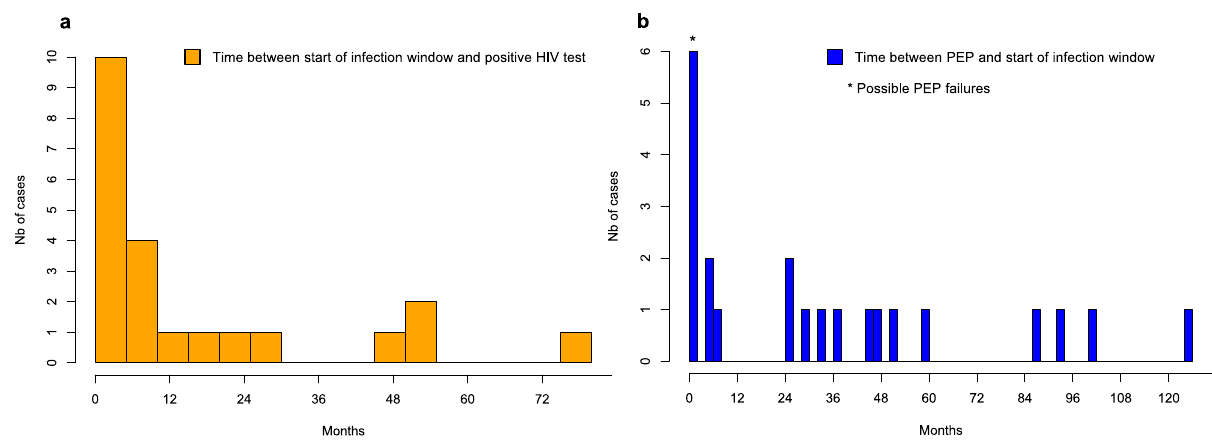
Fig. 3 Infection window and possible PEP failures: distribution among PEP seekers diagnosed with HIV ( n = 22). a Histogram showing the distribution of time between the earliest possible infection date and HIV diagnosis (orange bars). In 17 cases, the possible infection window was shorter than 2 years. b Histogram showing the distribution of time between PEP consultation and the start of the infection window (dark blue bars). PEP failure was possible in 6 cases (illustrated with *): the start of the infection window occurred within 3 months of PEP consultation ( n = 5), or HIV was diagnosed at 3 months ( n = 1). PEP: post-exposure